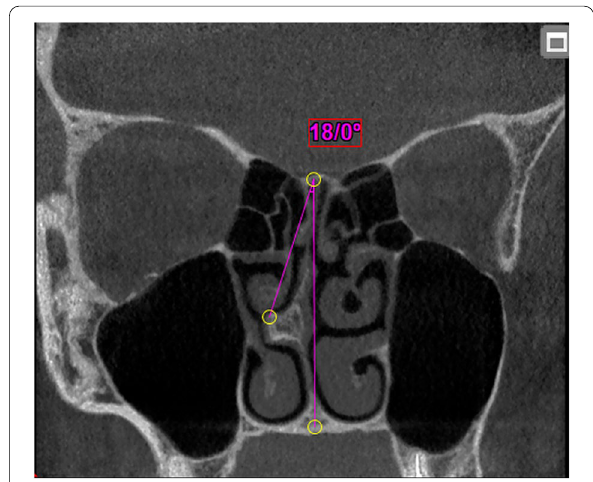
Fig. 2 Measuring the NSD (°) in the coronal plane